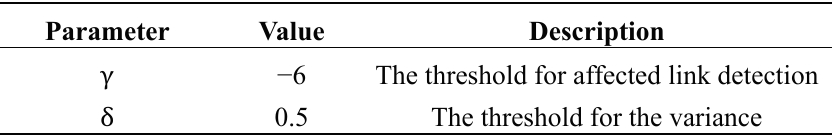
Table 4. The parameters of NOOLR.